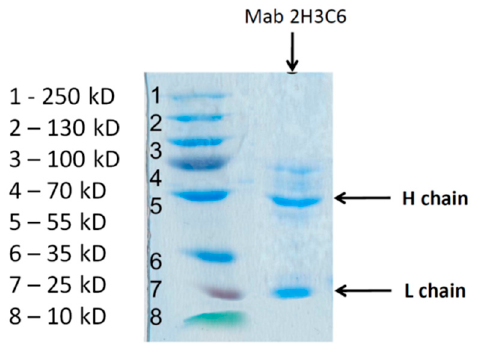
Figure 5. Results of SDS-electrophoresis of Mab 2H3C6 in a polyacrylamide gel.